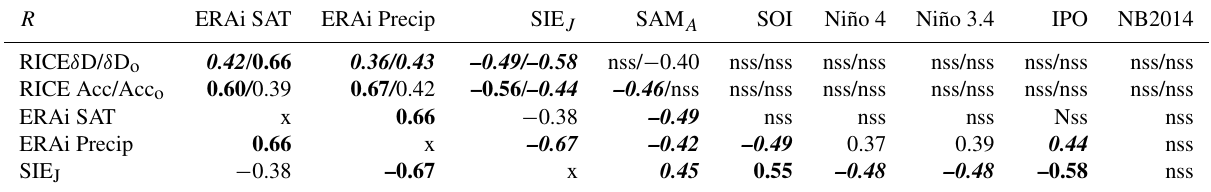
Table 2. Overview of correlation coefficients for annual means of the common time period 1979–2012 between climate parameters, proxies and indices: the original RICE ( δ D) and optimised ( δ D o ) data (this paper), the original RICE Acc (Winstrup et al., 2017), and data adjusted to the revised age scale of δ D o – Acc o , ERAi SAT and precipitation (ERAi Precip; Dee at el., 2011), Ross–Amundsen Sea SIE J (Jones et al., 2016), SAM A (Abram et al., 2014), SOI (Trenberth and Stepaniak, 2001), Niño 4 Index (Trenberth and Stepaniak, 2001), Niño 3.4 (Emile-Geay et al., 2013), Inter-decadal Pacific Oscillation (IPO) Index (Henley et al., 2015), and NB2014. Significance values are adjusted for degree of freedom depending on the length of the time series. Only correlation coefficients exceeding 95% ( r ≥ 0 . 34, n = 34) are shown; bold italic values exceed 99% ( r ≥ 0 . 42, n = 34); bold values exceed 99.9% ( r ≥ 0 . 54, n = 34). SAM A and IPO have been adjusted for a lower degree of freedom (df = 28) as the reconstructions end in 2007. “Nss” denotes “not statistically significant”. Correlation between RICE δ D and RICE Acc is r = 0 . 49, p< 0 . 01; correlation between RICE δ D o and RICE Acc o is r = 0 . 62, p< 0 . 01. R ERAi SAT ERAi Precip SIE